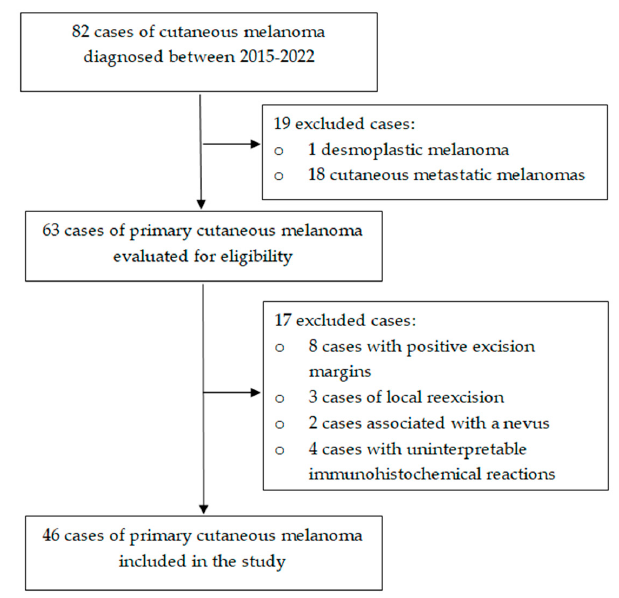
Figure 1. Flow chart illustrating the case selection for the study.